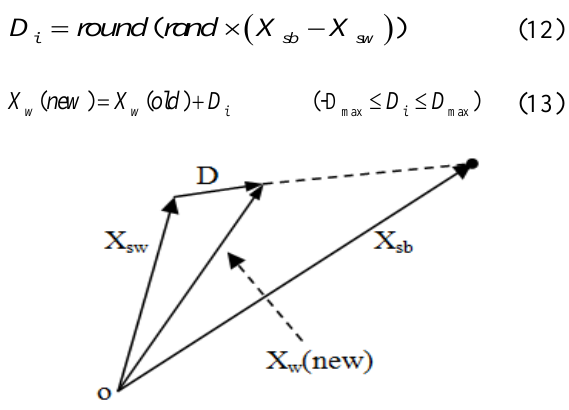
Figure 4. The original of the frog leaping rule